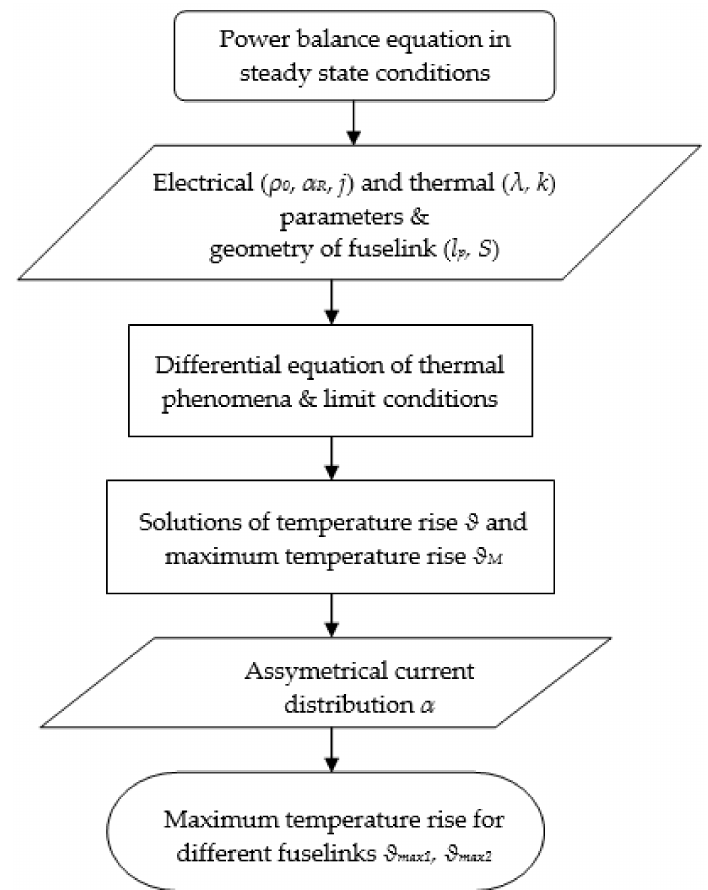
Figure 1. Fllowchart of the mathematical